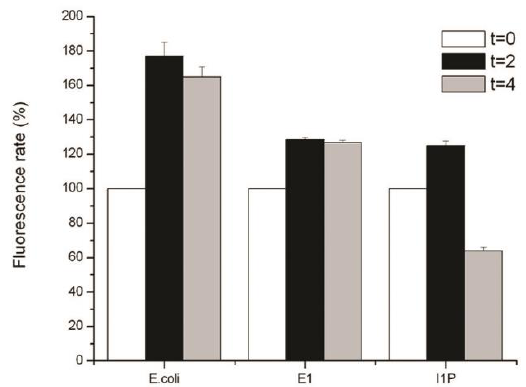
Figure 2. Intracellular levels of reactive oxygen species (ROS) measured with the oxidant-sensing probe 2’,7’-dichlorodihydrofluorescein diacetate. Cells were exposed to UV-C radiation for 2 and 4 min and their fluorescence intensity compared to the unexposed control (time 0), which was assigned 100% of the fluorescence. Measurements were performed in